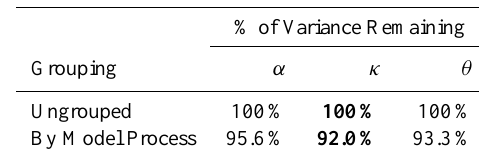
Table 3. Variance reduction in the parameters of the mixed gamma distribution grouped by dominant model